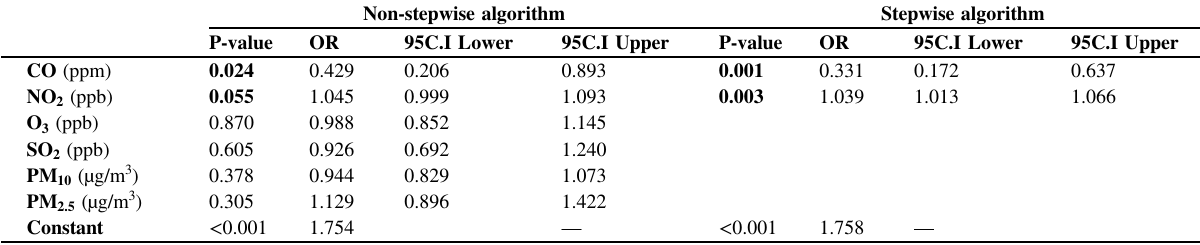
Table 2 Evaluation the impact of pollutants on mammographic breast density with stepwise and non-stepwise logistic regression. Non-stepwise algorithm Stepwise algorithm